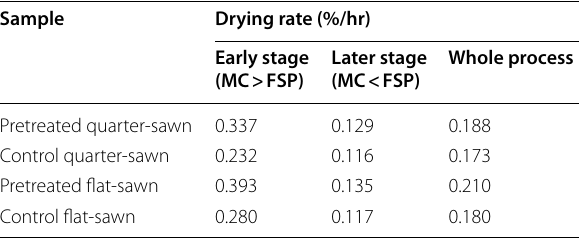
Fig. 4 Conventional drying curves of MW-pretreated and control wood samples